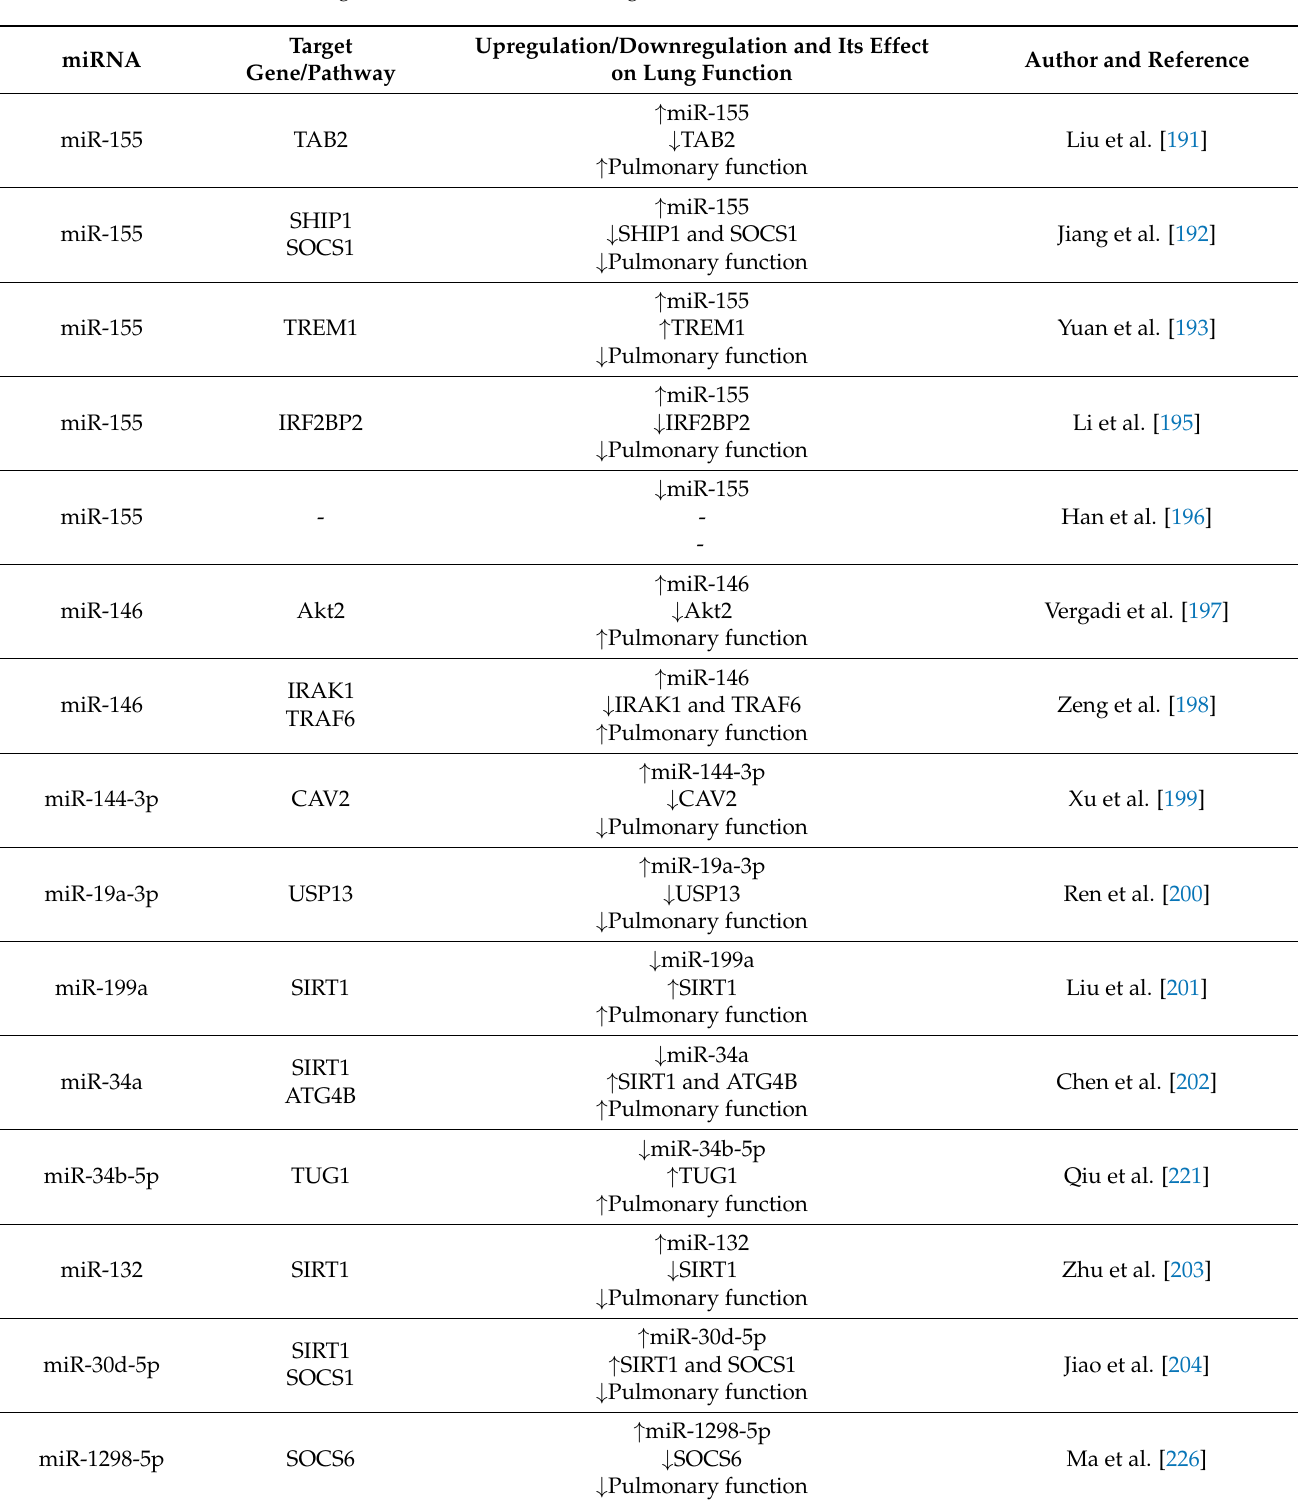
Table 10. miRNAs involved in sepsis-induced lung dysfunction and their targets. ↑ indicates up regulation, ↓ indicates down